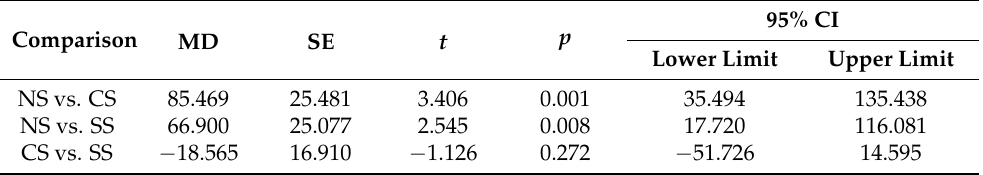
Table 2. Results of between-group post hoc analysis with an LSD test.